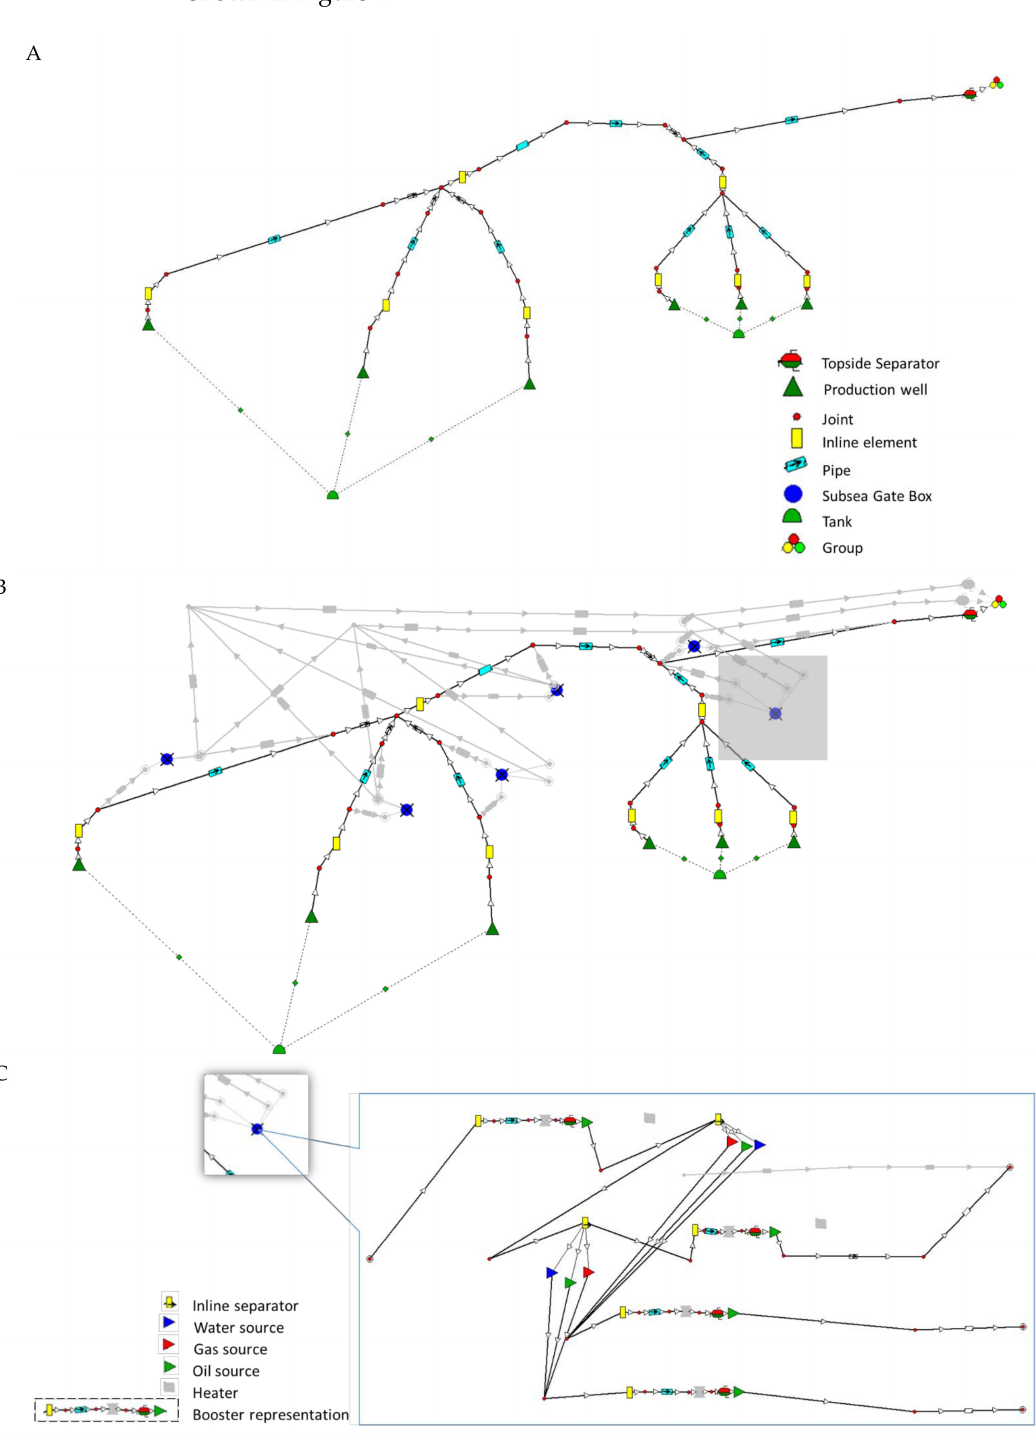
Figure 4. Superstructure example. ( A ) Original field layout from the input file, ( B ) superstructure file, and ( C ) subsea gate box internal